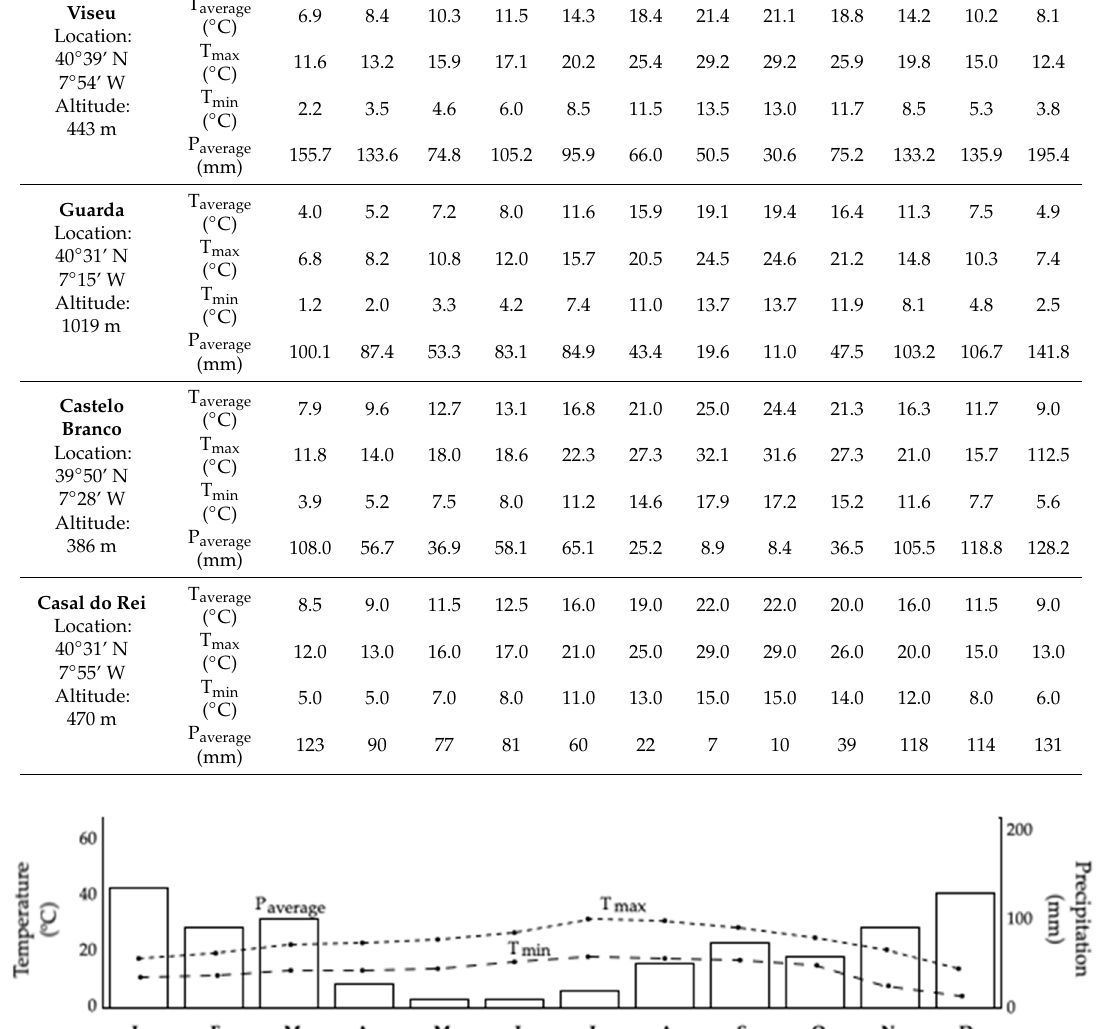
Figure 3. Air temperature and precipitation based on the information available in Table 1 for Casal do Rei using the values modeled with METEOBLUE (https://www.meteoblue.com). In the figure, the maximum temperature (T max ), minimum temperature (T min ), and precipitation are represented.